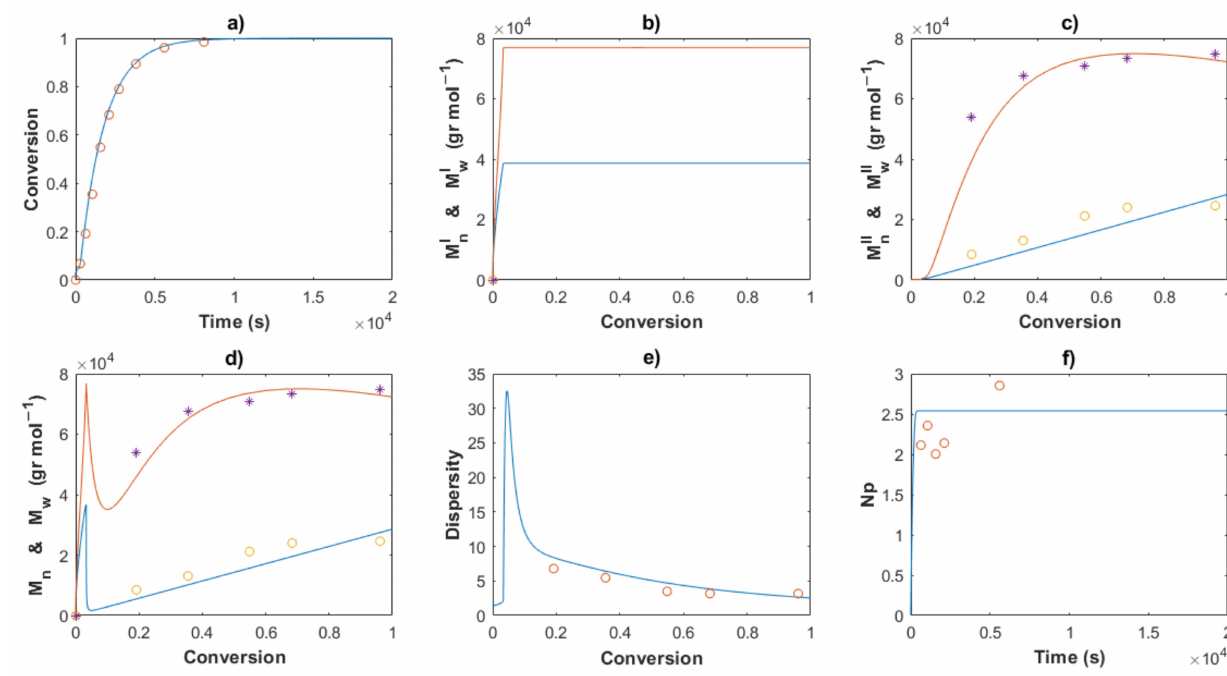
Figure 8. Comparison between the experimental data (symbols) and the model solutions (lines) for the Exp 5: ( a ) Conversion profiles, ( b ) M nI and M wI versus conversion, ( c ) M nII and M wII versus conversion, ( d ) M n and M w versus conversion, ( e ) Dispersity, ( f ) Np versus